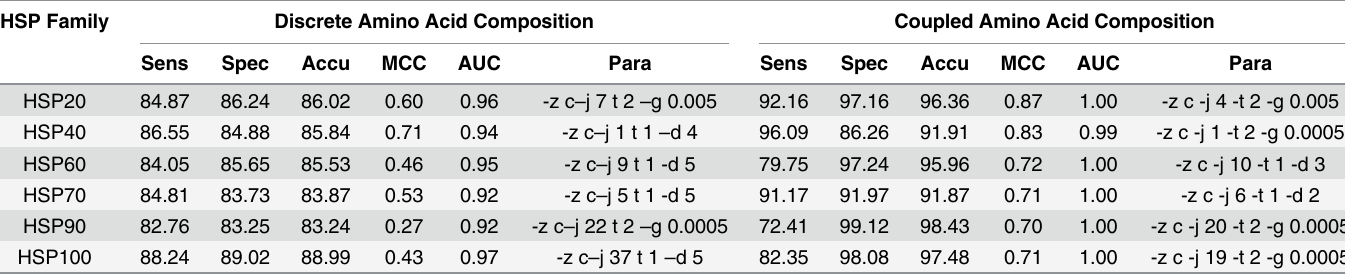
Table 4. Performance of discrete amino acid and coupled amino acid composition based SVM models during LOOCV at 2 nd tier. HSP Family